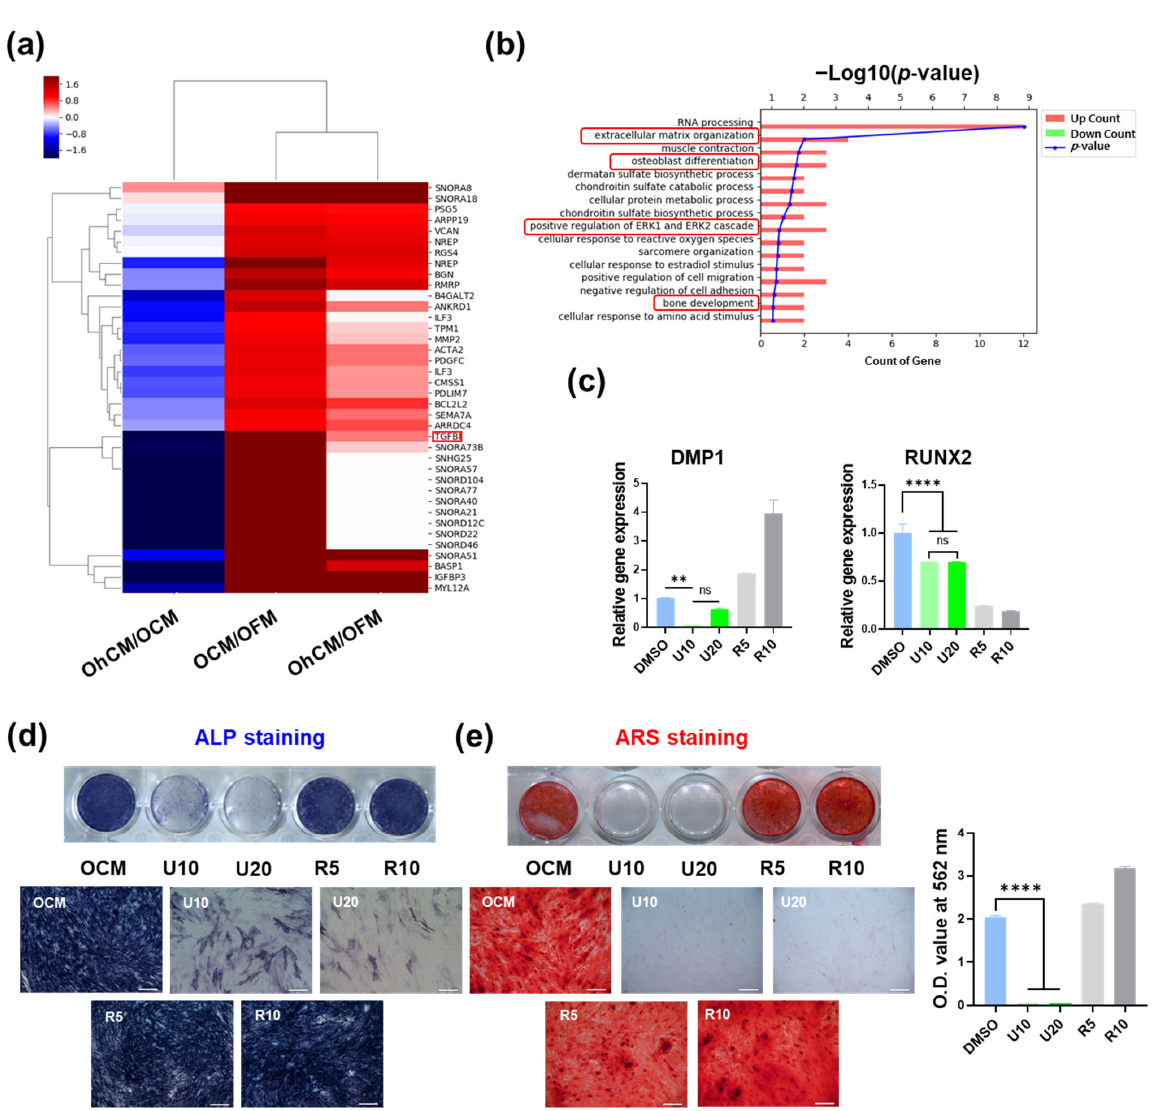
(Figure 5d,e). Collectively, the odonto/osteogenic effect of hGF-CM is highly involved in the ERK pathway.